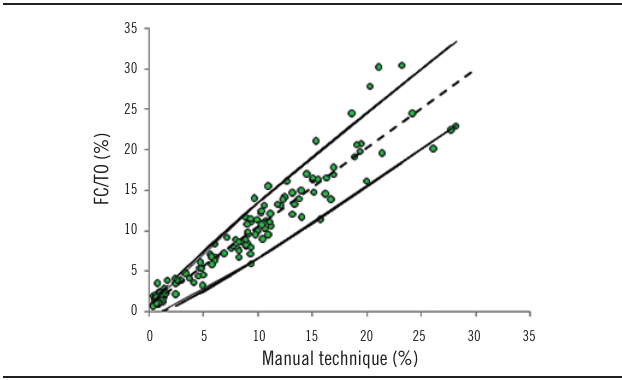
figurE 2 − Reticulocyte count (%) by the manual method and by FC/TO ( n = 150) Continuous lines: 95% binomial confidence interval; traced line: linear regression between the evaluated methods; Y = 0.827 + 0.97X; r 2 = 0.92; r = 0.959. FC/TO: method of reticulocyte count by flow cytometry, using thiazole orange.